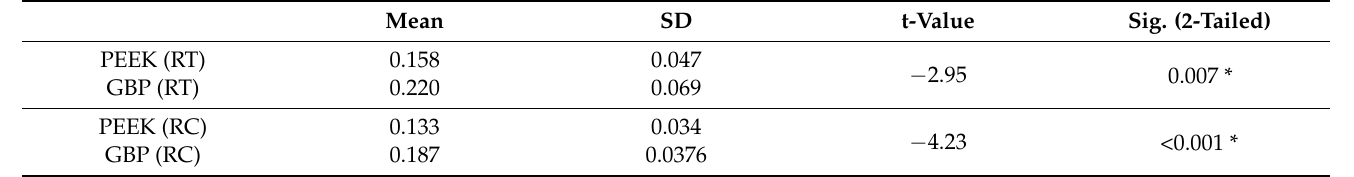
Table 3. Mean, standard deviation, and significant difference of the deformations (in mm) between PEEK and GBP clasps’ retentive arms and between their reciprocal arms of the studied